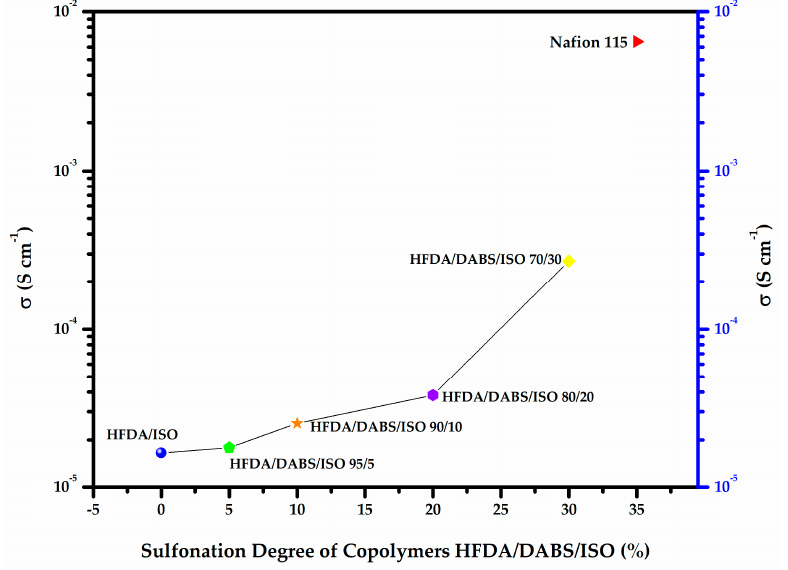
Figure 5. Proton conductivity of HFDA/ISO and HFDA/DABS/ISO membranes as a function of sulfonation degree compared to Nafion ® 115.